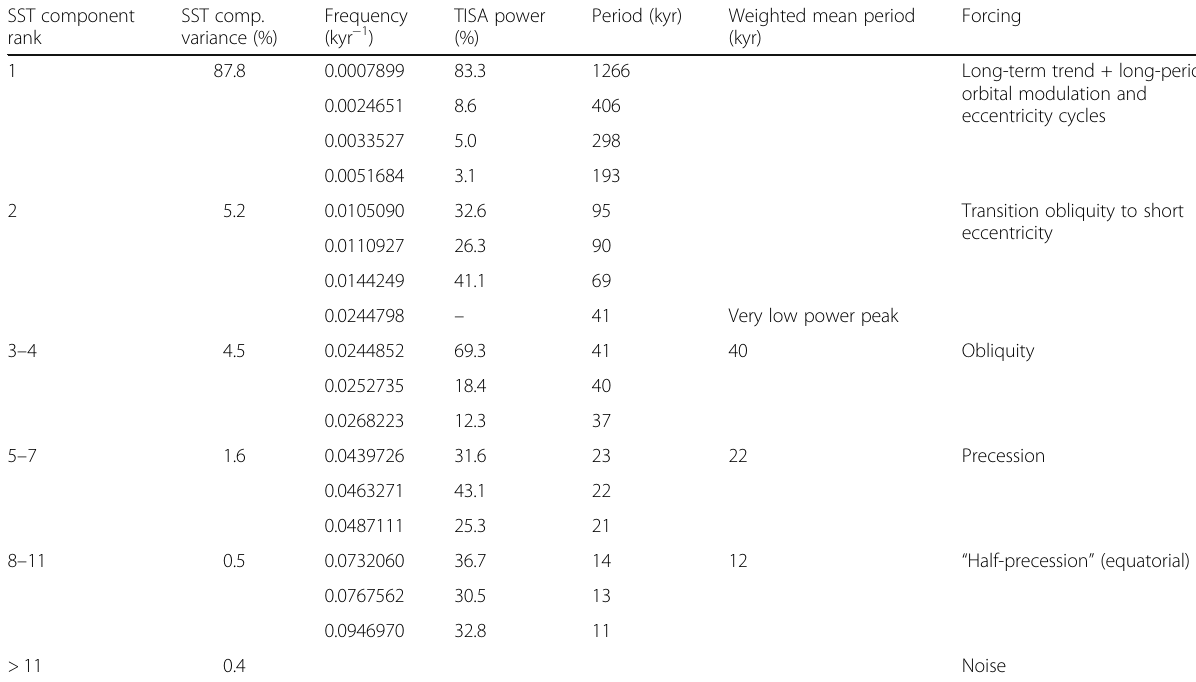
Table 4 Main descriptive parameters and Fourier frequency results of the five ODP Site 846 SST components isolated by singular spectrum analysis. Original SST data from Herbert et al. (2010b) resampled at 1 kyr